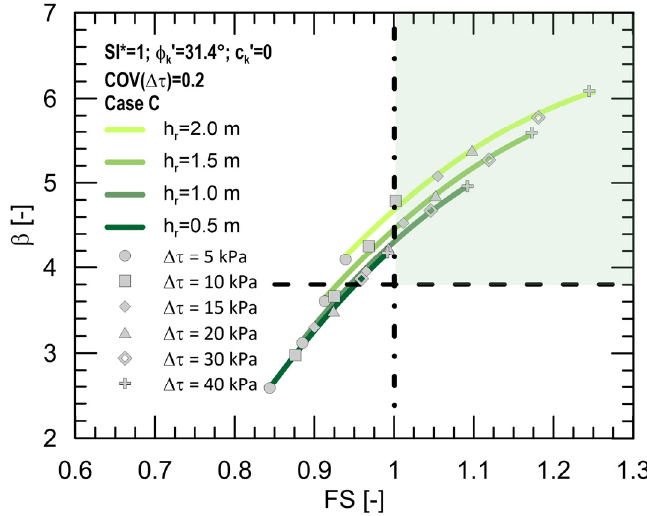
Figure 5. β ‐ FS curves for varying  τ and h r , for ϕ k ′ = 31.4°, COV (  τ ) = 20% and seismic case C. Figure 5. β - FS curves for varying ∆ τ and h r , for φ k (cid:48) = 31.4 ◦ , COV ( ∆ τ ) = 20% and seismic case C.